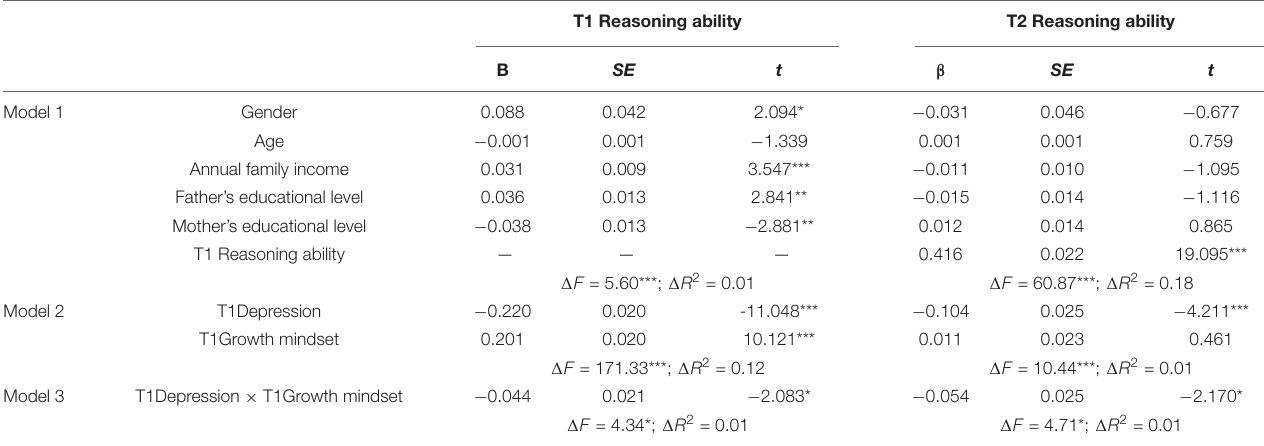
TABLE 3 | Regression analysis for the variables to predict Reasoning ability.